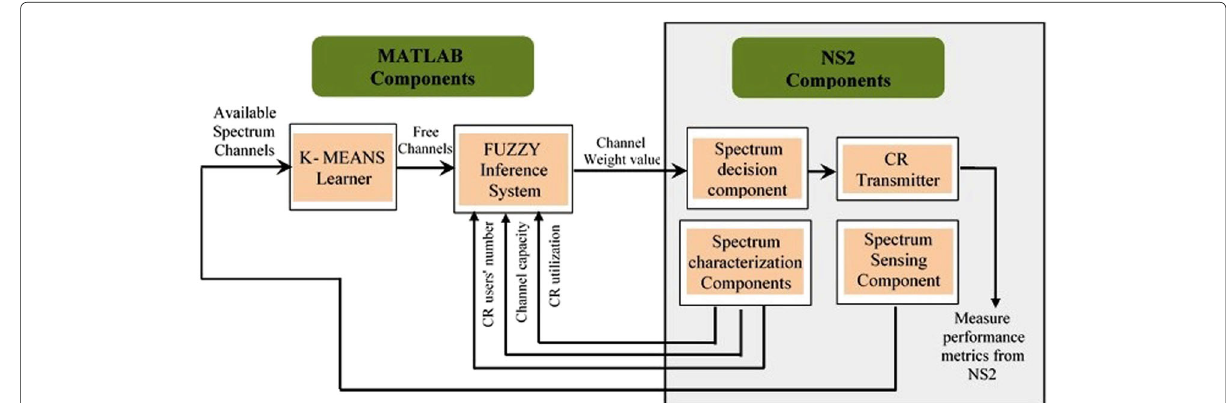
Fig. 6 The work flow between MATLAB and